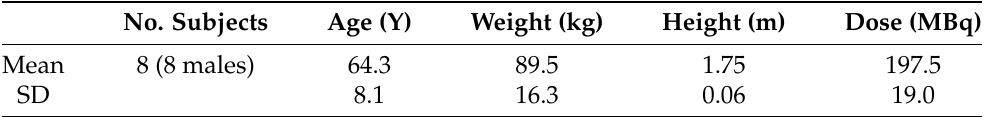
Table 1. Summary of the population characteristics of this study in terms of the mean and the standard deviation